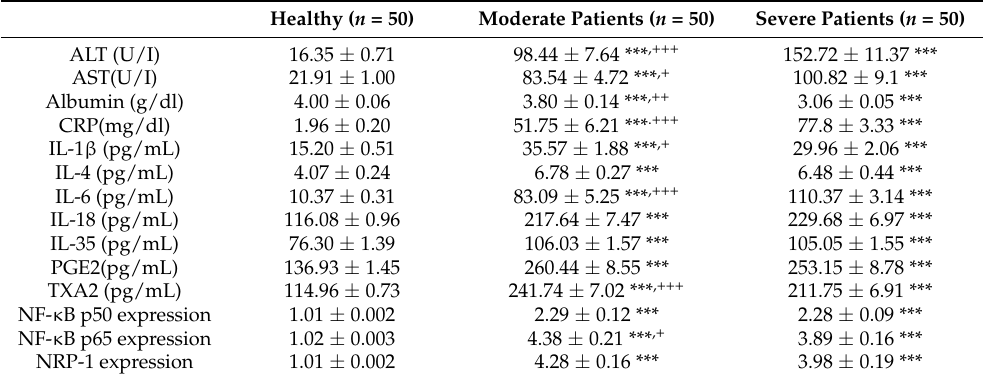
Table 1. Comparison of Liver function tests; CRP; cytokine levels; PGE2; TXA2; NF- κ B p50, NF- κ B p65 and NRP-1 in the studied